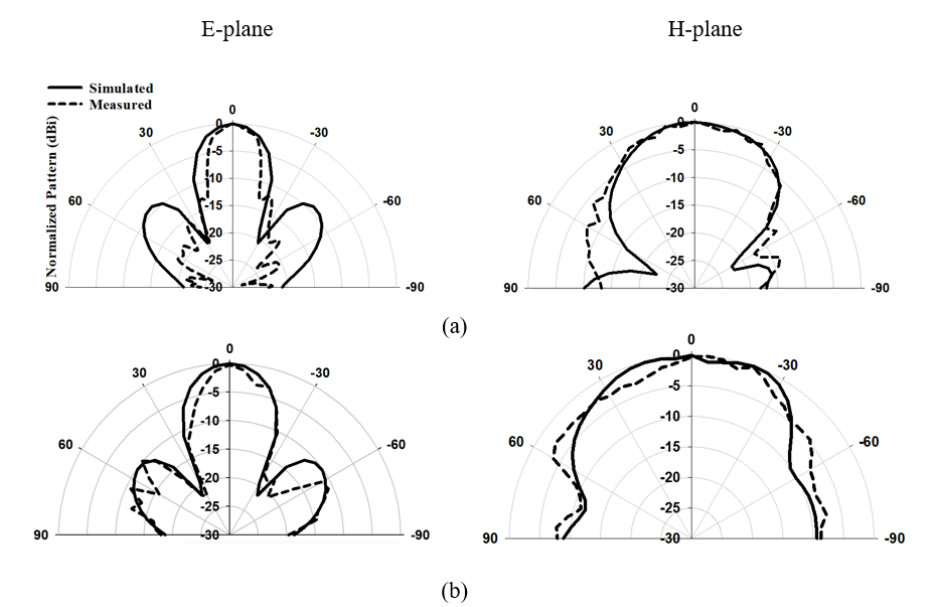
Figure 9. The E and H planes radiation patterns for an array of two hemispherical DRAs with outlined positions on the ground plane ( a ) 22.7 GHz ( b ) 27 GHz.